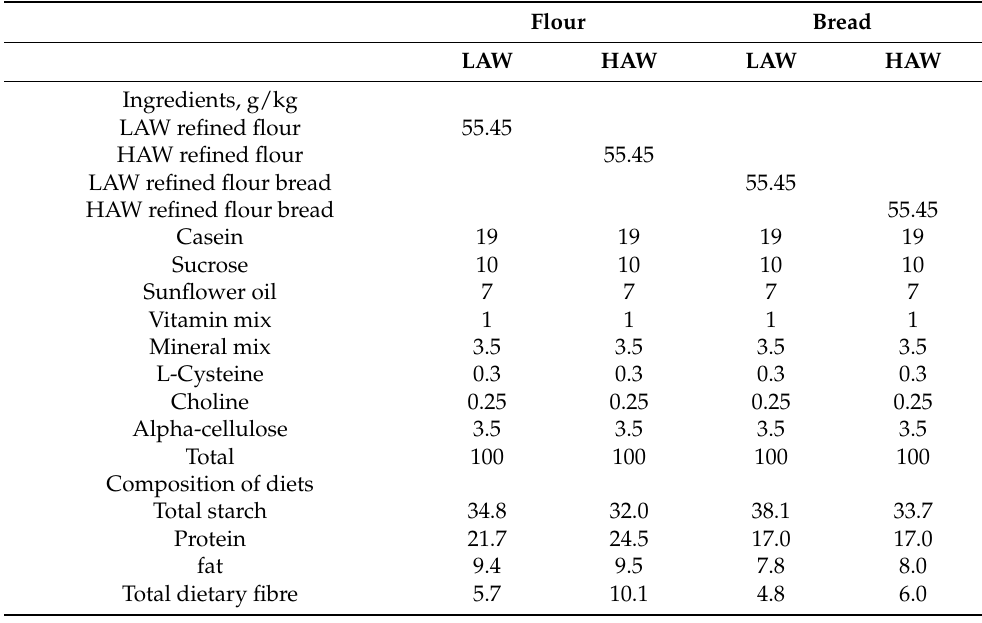
Table 4. Ingredient analysed and calculated composition of rat intervention test diets (as fed). Flour